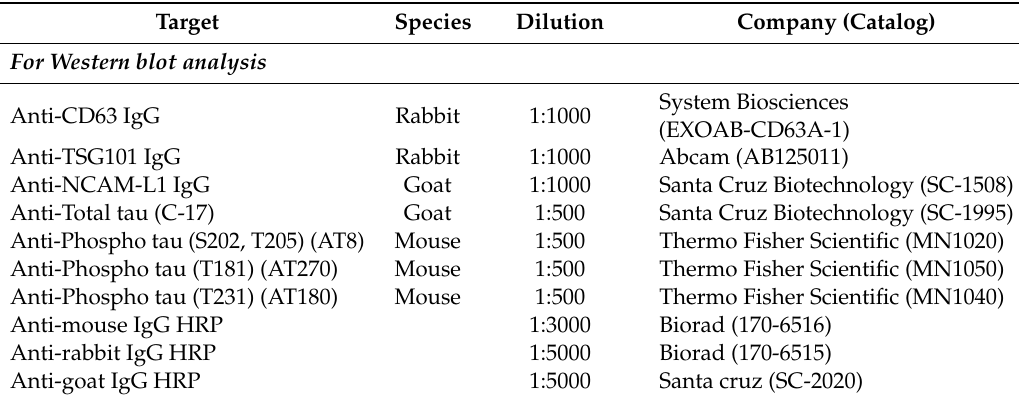
Table 2. Antibodies and ELISA kits used in this